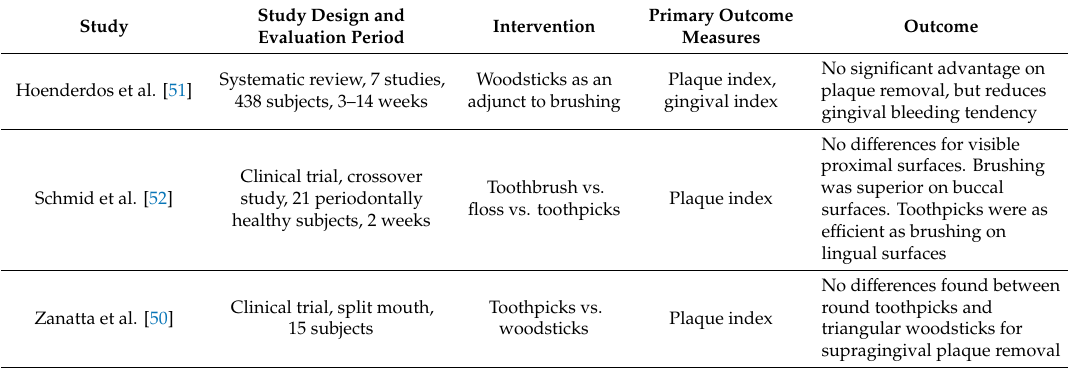
Table 3. Summary of included studies on the use of woodsticks and